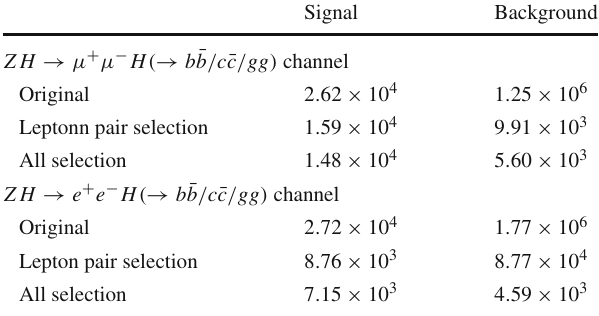
Table 1 Event yields of cut flow. Signal events are Z H → l + l − H , H → b ¯ b / c ¯ c / gg combined. Background is the e + e − /μ + μ − + jet pair